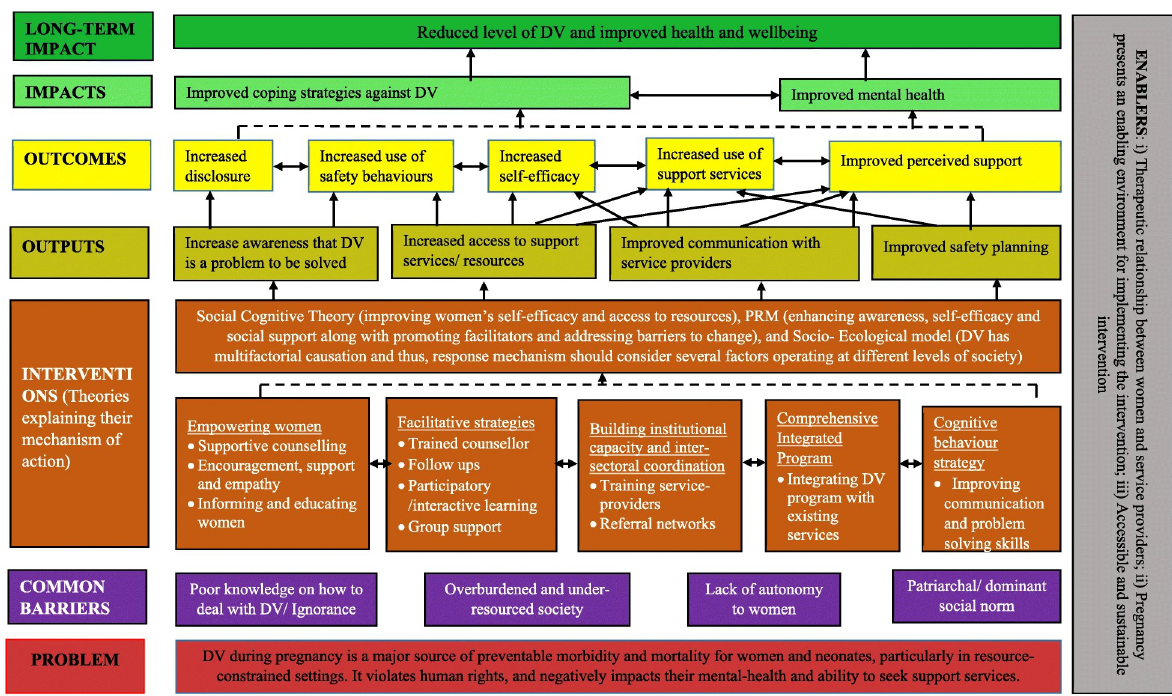
Fig 3. PRISMA flowchart. Source: authors’ elaboration, adapted from PRISMA 2020 [35].